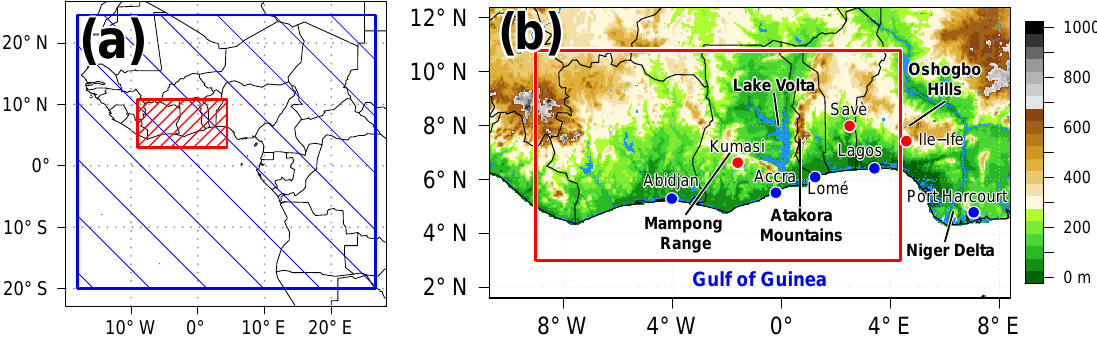
Figure 1. (a) Modeling domain SWA (red rectangle, 2.5km grid mesh size) together with its coarse domain (blue, 5km grid mesh size). (b) Map of the research area SWA. The color shading denotes the topography (meters above sea level, a.s.l.). Topographic features are named in bold, coastal cities are shown as blue dots and the three DACCIWA supersites as red dots. The modeling domain SWA is again denoted with a red rectangle.